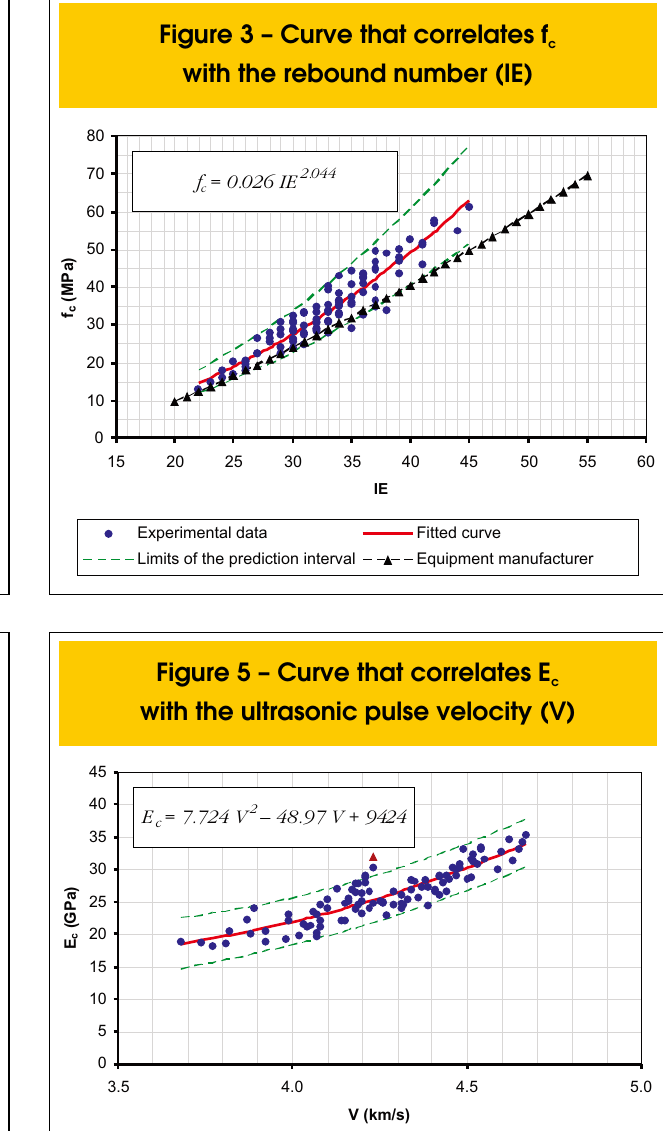
Figure 3 – Curve that correlates f with the rebound number (IE)